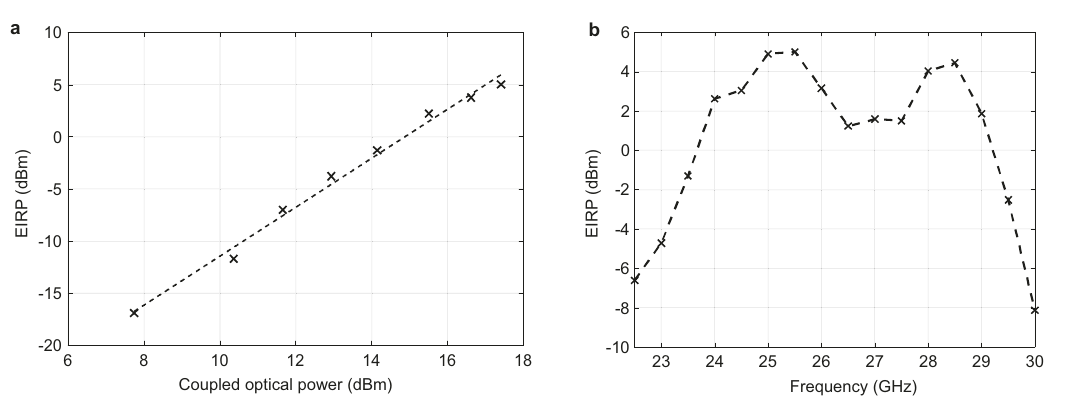
Fig. 6 | EIRP measurement. a EIRP increasing quadratically with input optical power. b EIRP vs heterodyne frequency.